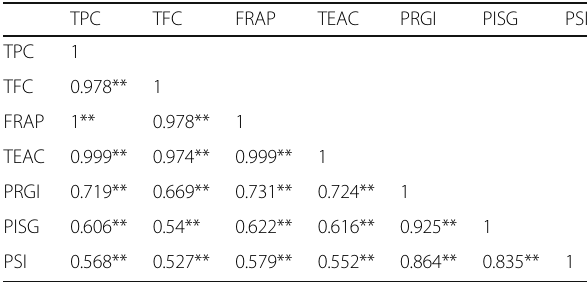
TPC total phenolic content, TFC total flavonoid content, FRAP ferric-reducing antioxidant power, TEAC Trolox equivalent antioxidant capacity, PRGI percentage of radial growth inhibition, PISG percentage of inhibition of spore germination, PSI percentage of sporulation inhibition, ** p < 0.01